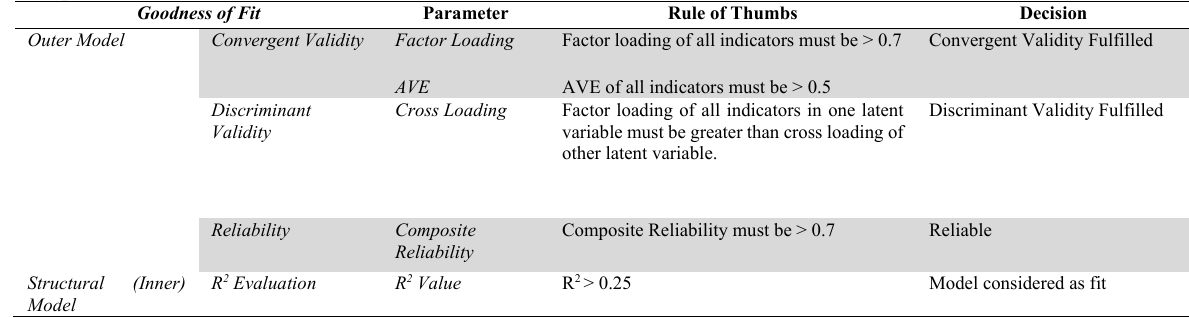
Recapitulation of Goodness of Fit Test on All Models